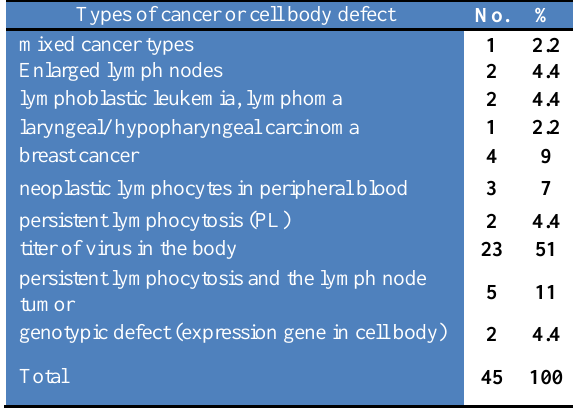
Table, 4: Pathological and clinical pathology changes described in cases of the studies.